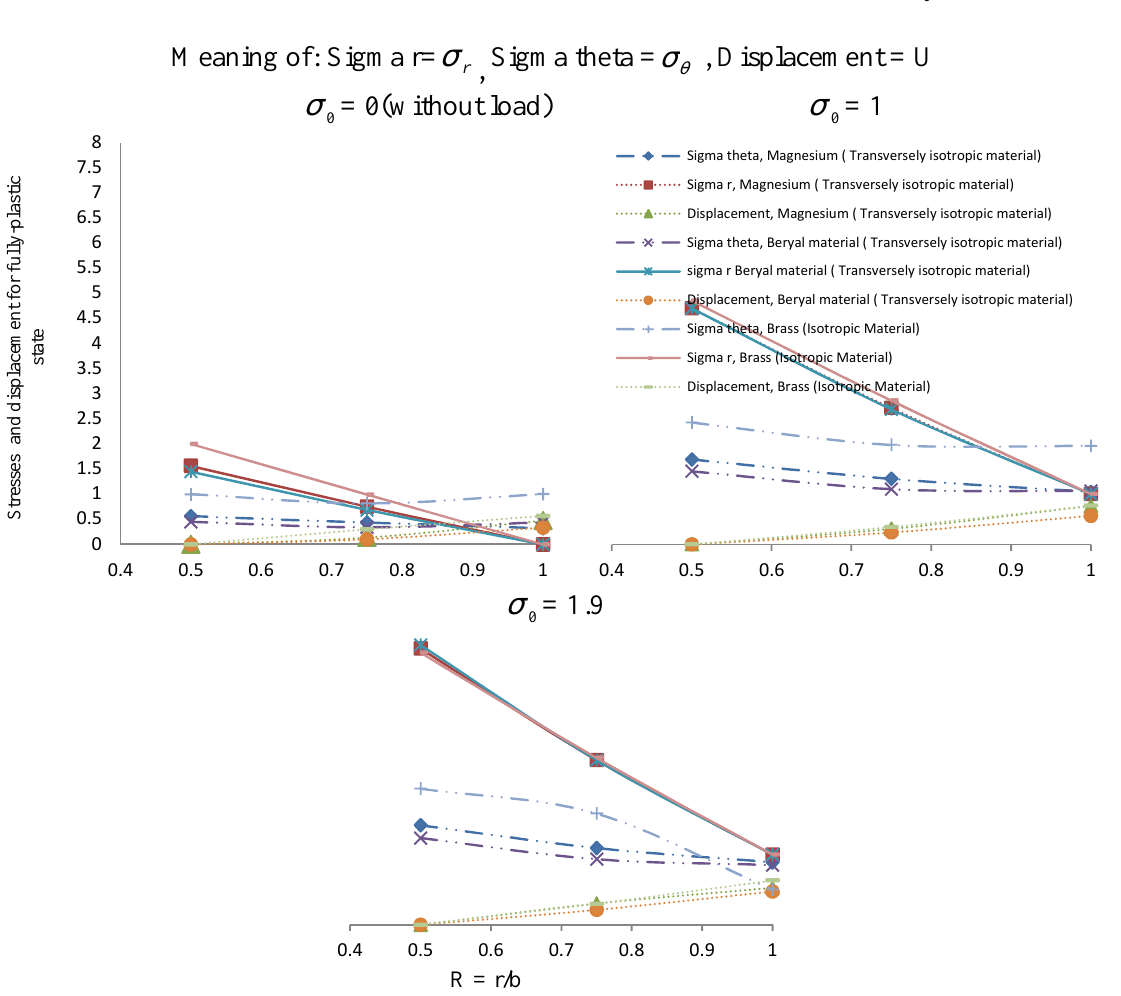
Figure 1. Angular speed required for initial yielding along the radii ratio